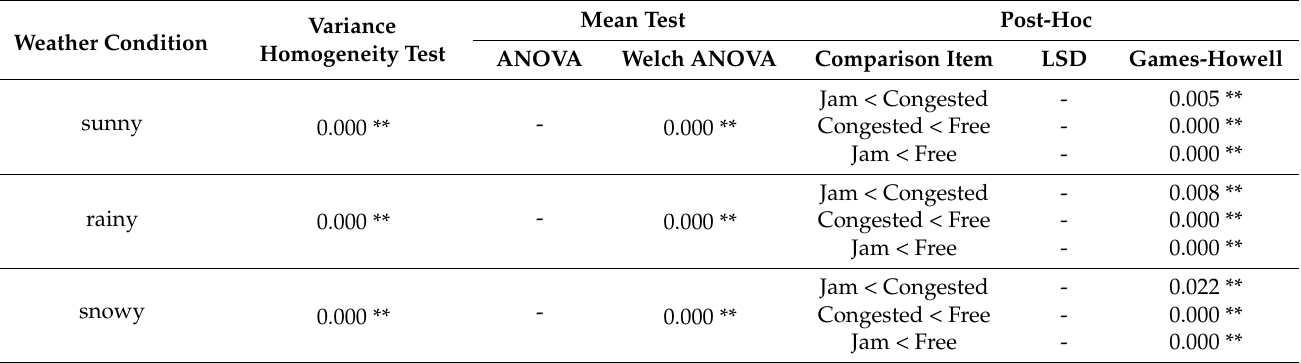
Table 5. Significance test of the influence of traffic flow on the minimum distance headway.